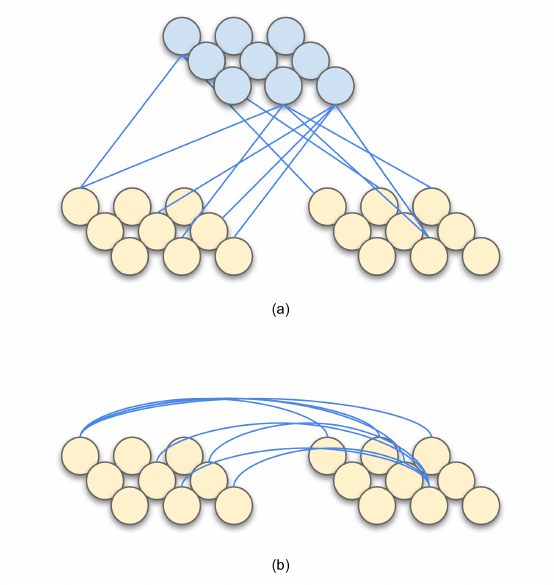
Figure 1. Schematic representation of ( a ) Convergence Divergence Zone (CDZ) and ( b ) reentry frameworks. The reentry paradigm states that unimodal neurons connect to each other through direct connections, while the CDZ paradigm implies hierarchical neurons that connect unimodal